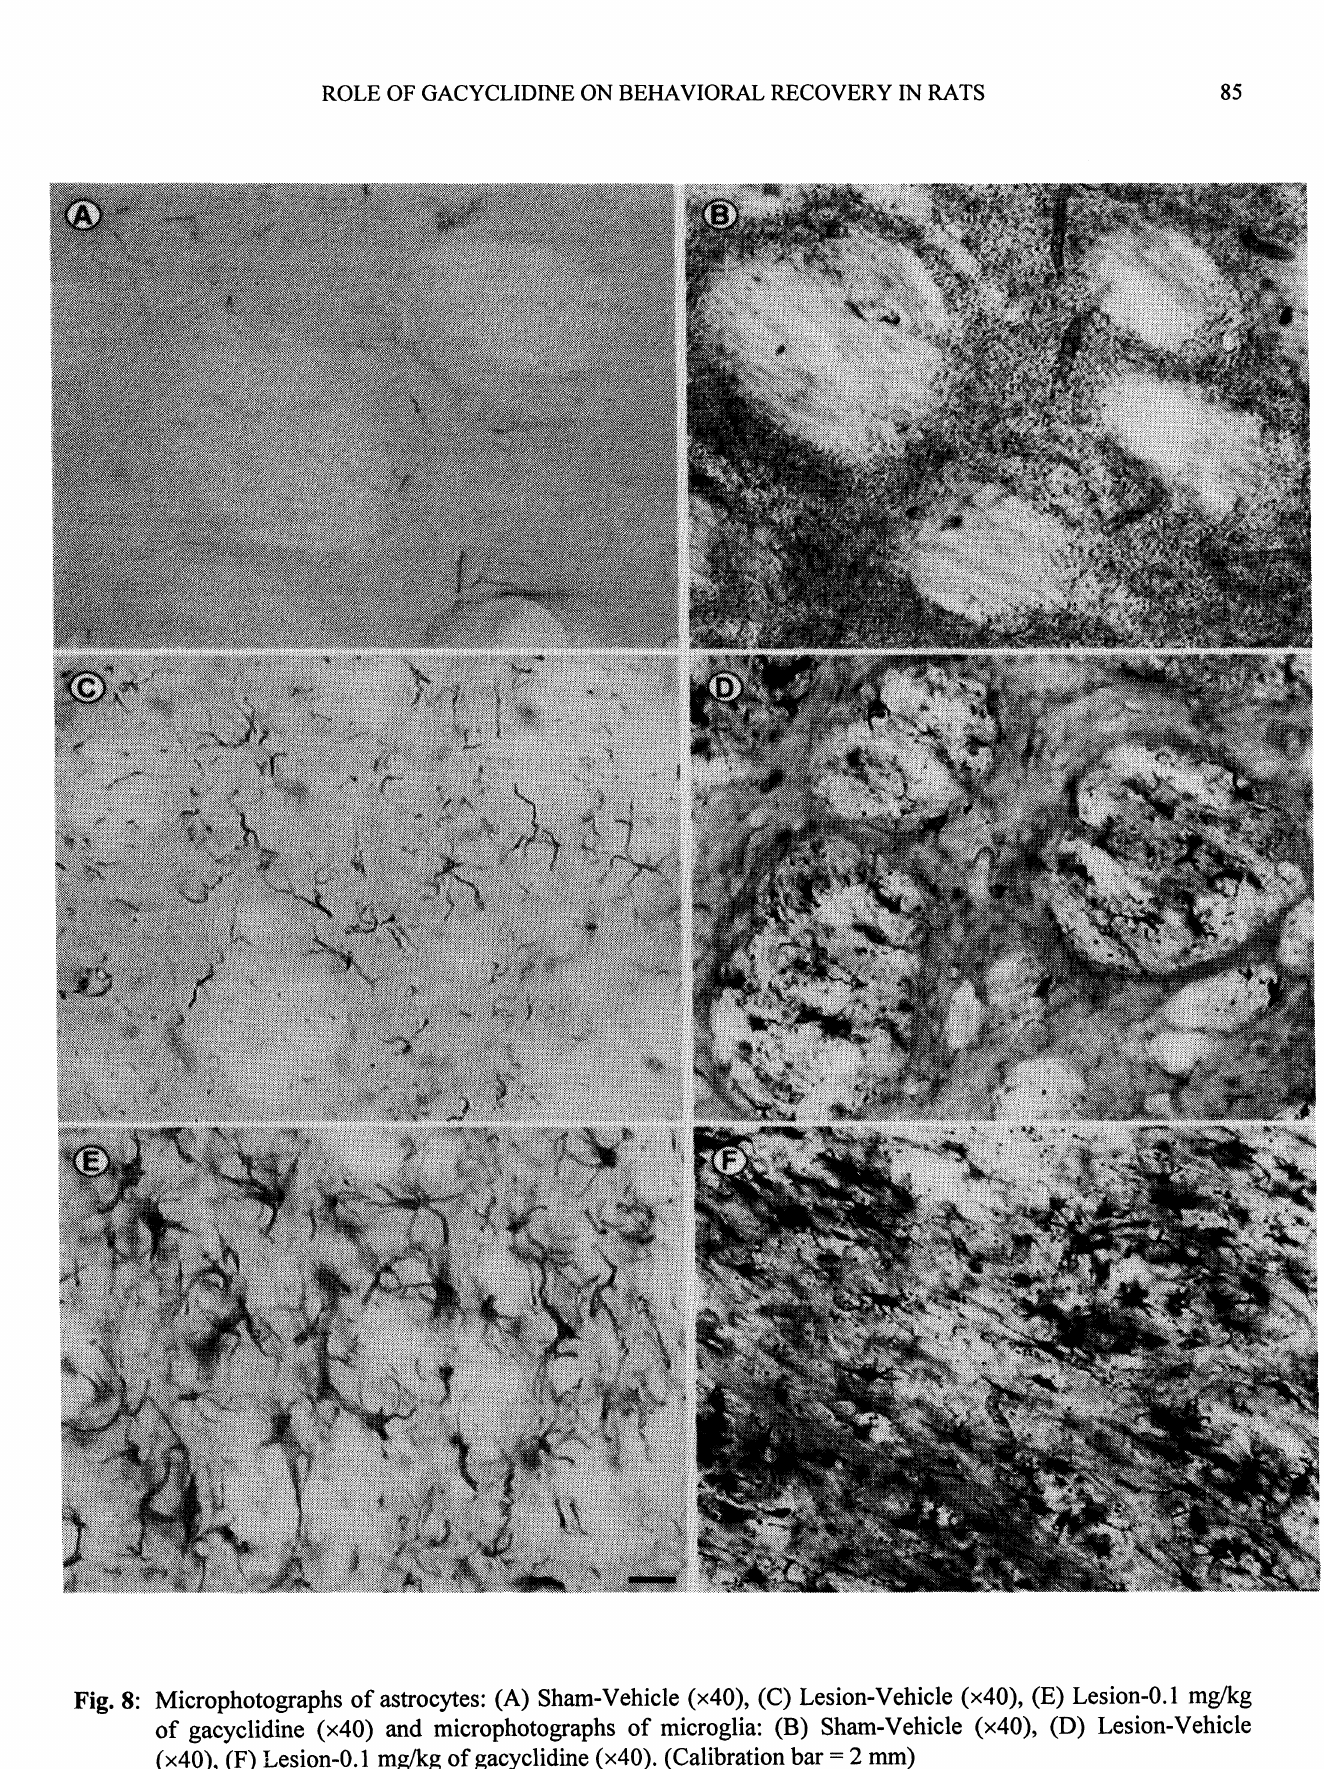
Fig. 8: Microphotographs of astrocytes: (A) Sham-Vehicle (x40), (C) Lesion-Vehicle (x40), (E) Lesion-0.1 mg/kg of gacyclidine (40) and microphotographs of microglia: (B) Sham-Vehicle (x40), (D) Lesion-Vehicle (x40), (F) Lesion-0.1 mg/kg of gacyclidine (x40). (Calibration bar 2